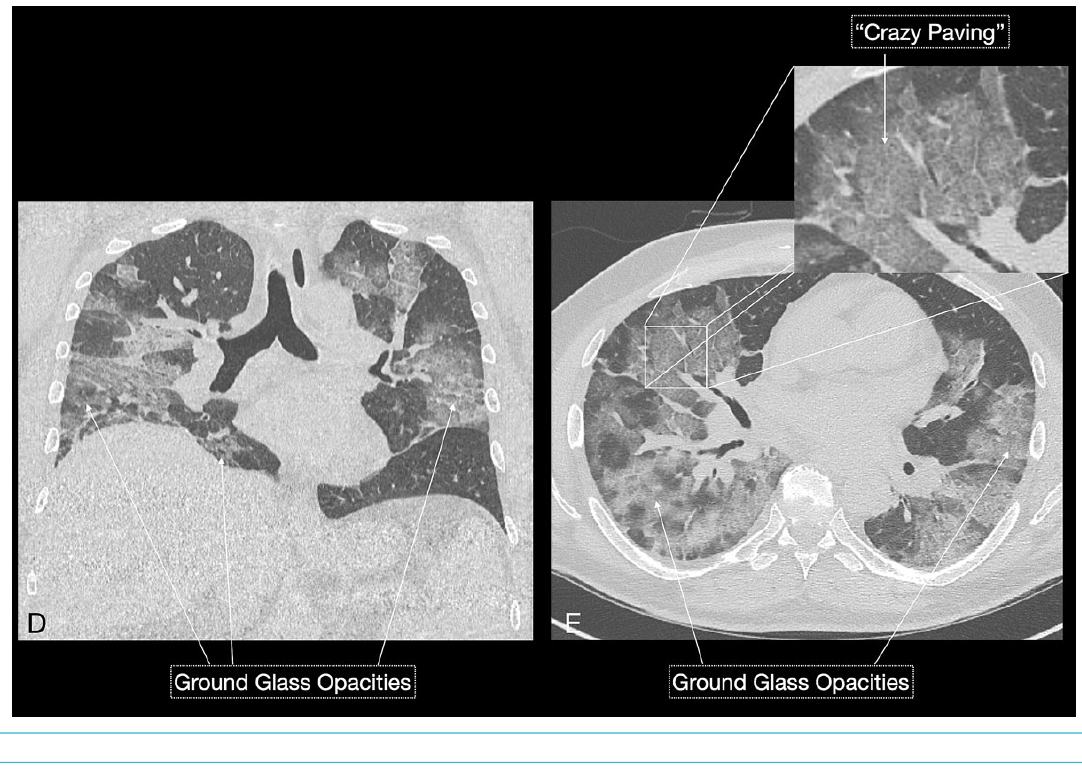
Figure 6 FG: Chest CT (F) and corresponding volume rendering (G) image demonstrated the increasing extent of diseased (orange) versus non-diseased (grey-blue) lung parenchyma.